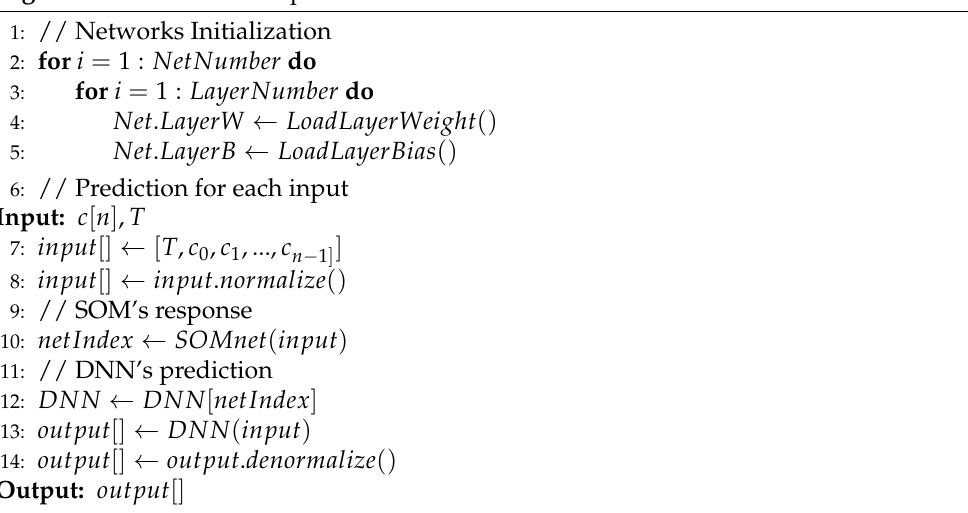
Algorithm 1 LIT inference